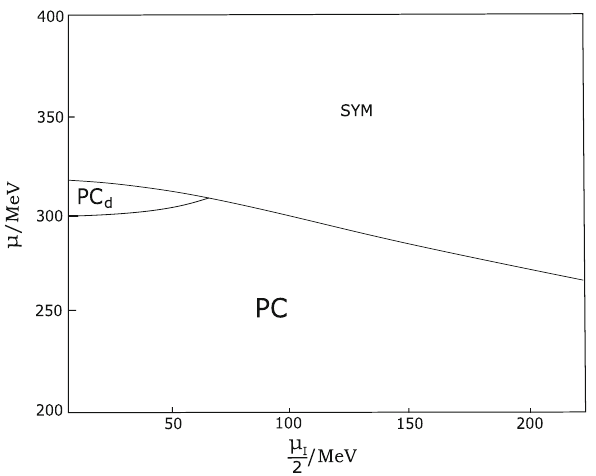
Fig. 1 The (μ I ,μ) -phase diagram of the model (4) in the chiral limit at μ Q = 0 and without charge neutrality and β -equilibrium condi- tions (and without chiral asymmetry). Here μ = μ B / 3, PC denotes the charged PC phase with zero baryon density, the PCd denotes the charged PC phase with nonzero baryon density. SYM corresponds to symmetrical phase of the model